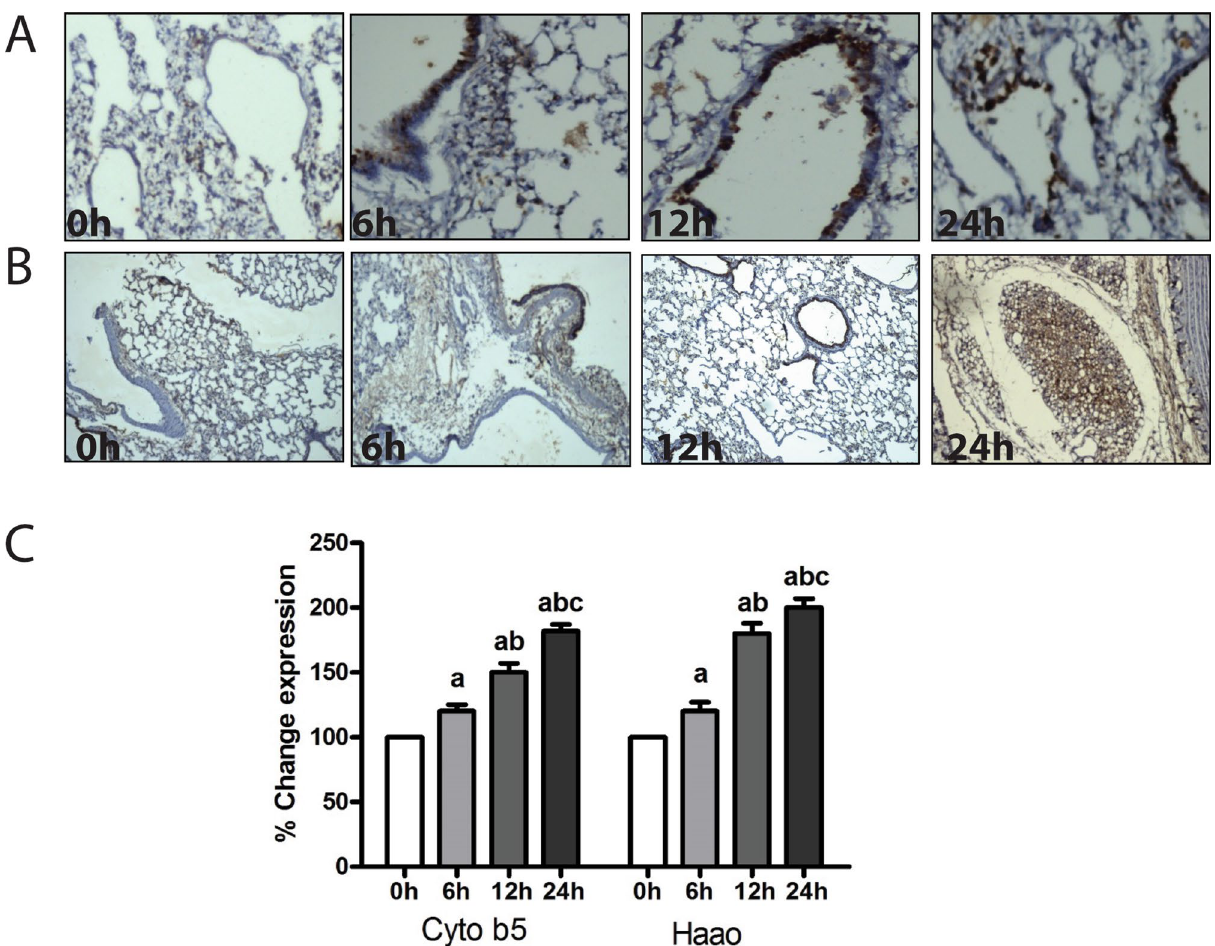
Figure 5. Immunohistochemical analysis of Haao and Cyb5a in rat lungs. ( A ) Immunostaining with an antibody to Haao of normoxic lung (0 h) compared with lung from hypoxic rats treated at different time points (6 h, 12 h and 24 h). Similarly, ( B ) immunostaining with an antibody to Cyb5a of normoxic lung (0 h) compared with hypoxic lung of rats treated at different time points (6 h, 12 h and 24 h). The results showed no positive immunoreactivity for Haao and Cyb5a in control rats (0 h) but Haao and Cyb5a stained strongly in hypoxic lung sections (6 h, 12 h and 24 h). Figure 5 ( C ) showed significantly higher levels of Haao and Cyb5a in hypoxia exposed lung tissues. Data were represented as Mean ± SD of three individual experiments. ‘a’ refers as P ≤ 0.05 with compare to normoxia, ‘b’ refers as P ≤ 0.05 with compare to 6 h hypoxia and ‘c’ refers as P ≤ 0.05 with compare to 12 h